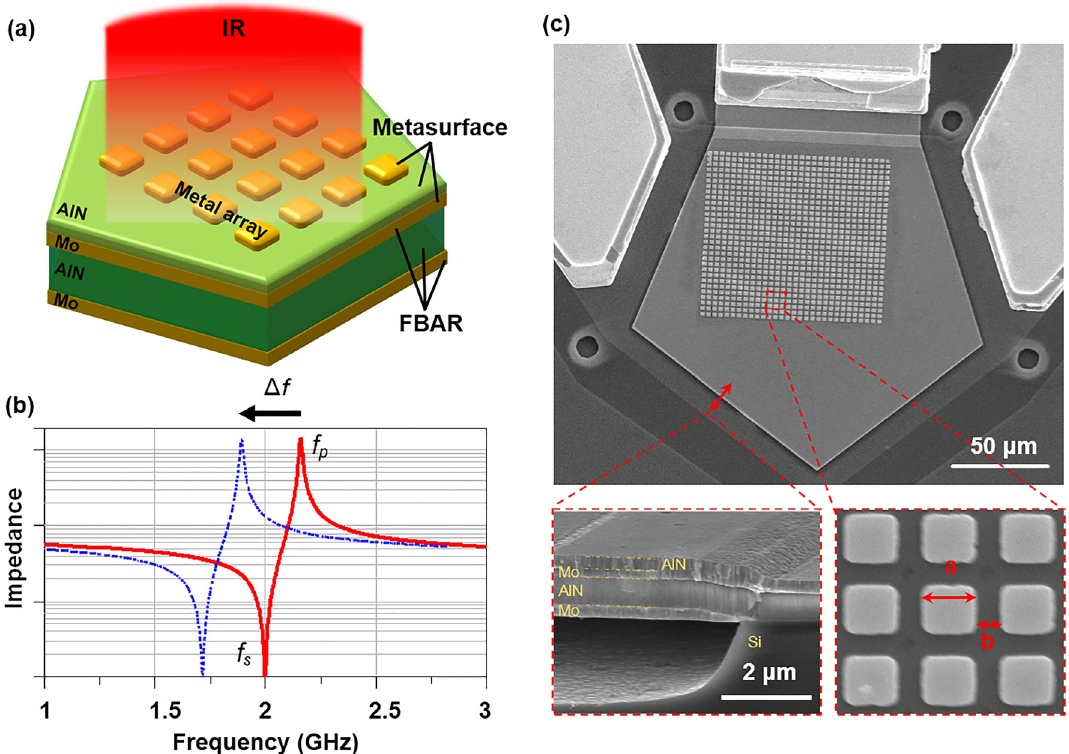
Figure 1: (a) Schematic layout of the proposed sensor. (b) Temperature-induced resonance frequency shifts down upon infrared (IR) irradi- ation. (c) Scanning electron microscope (SEM) image of the proposed sensor, cross-section of film bulk acoustic wave resonator (FBAR), and metal array of square plates. The length a of each square is ∼ 2 μ m and the gap spacing b between two neighboring squares is ∼ 1 μ